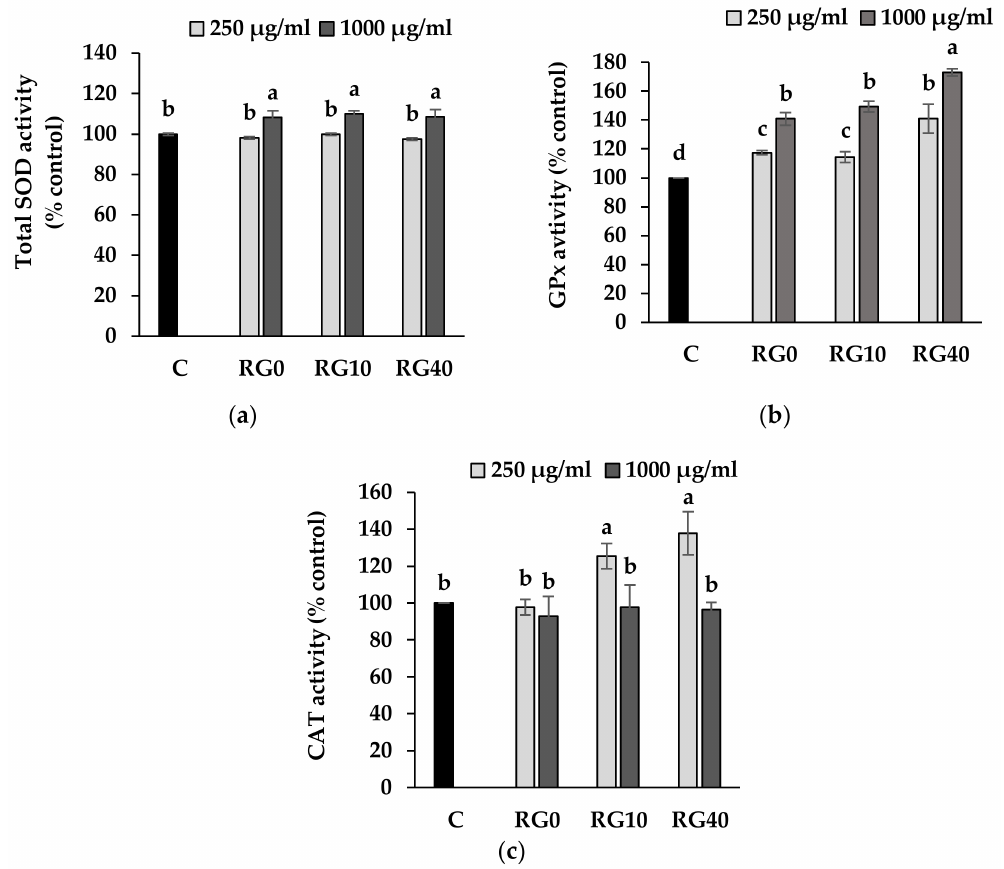
Figure 6. Level of SOD ( a ), GPx ( b ), and CAT ( c ) in RAW264.7 cell line treated with RG0, RG10, and RG40 compare to control. RG0; ricegrass juice extract (control), RG10; ricegrass juice fortified with 10 mg Se/L extract, RG40; ricegrass juice fortified with 40 mg Se/L extract. Data are means ± standard deviation (SD). Different letters indicated significant differences ( p < 0.05) in Duncan’s significant differences